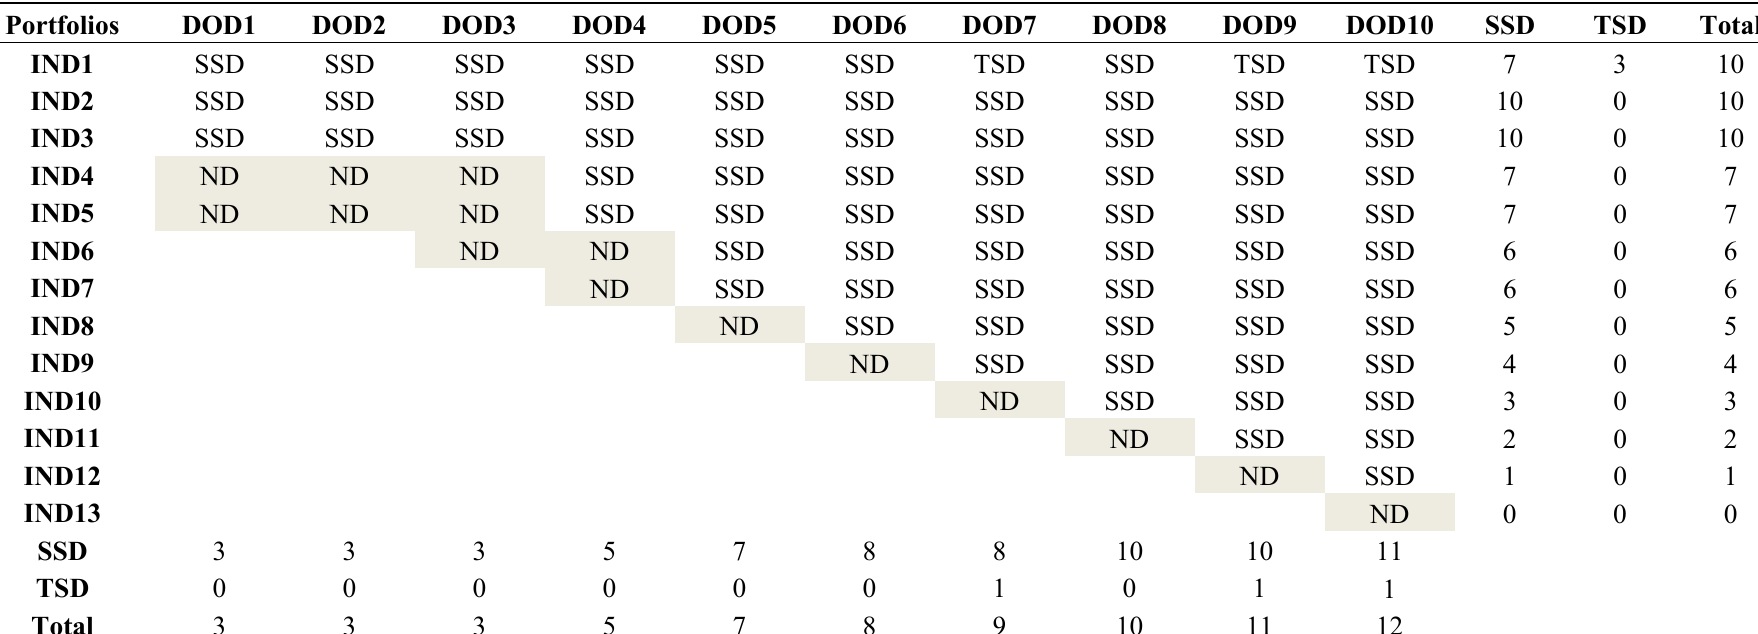
Table 5. Stochastic dominance test between global internationally and domestically diversified